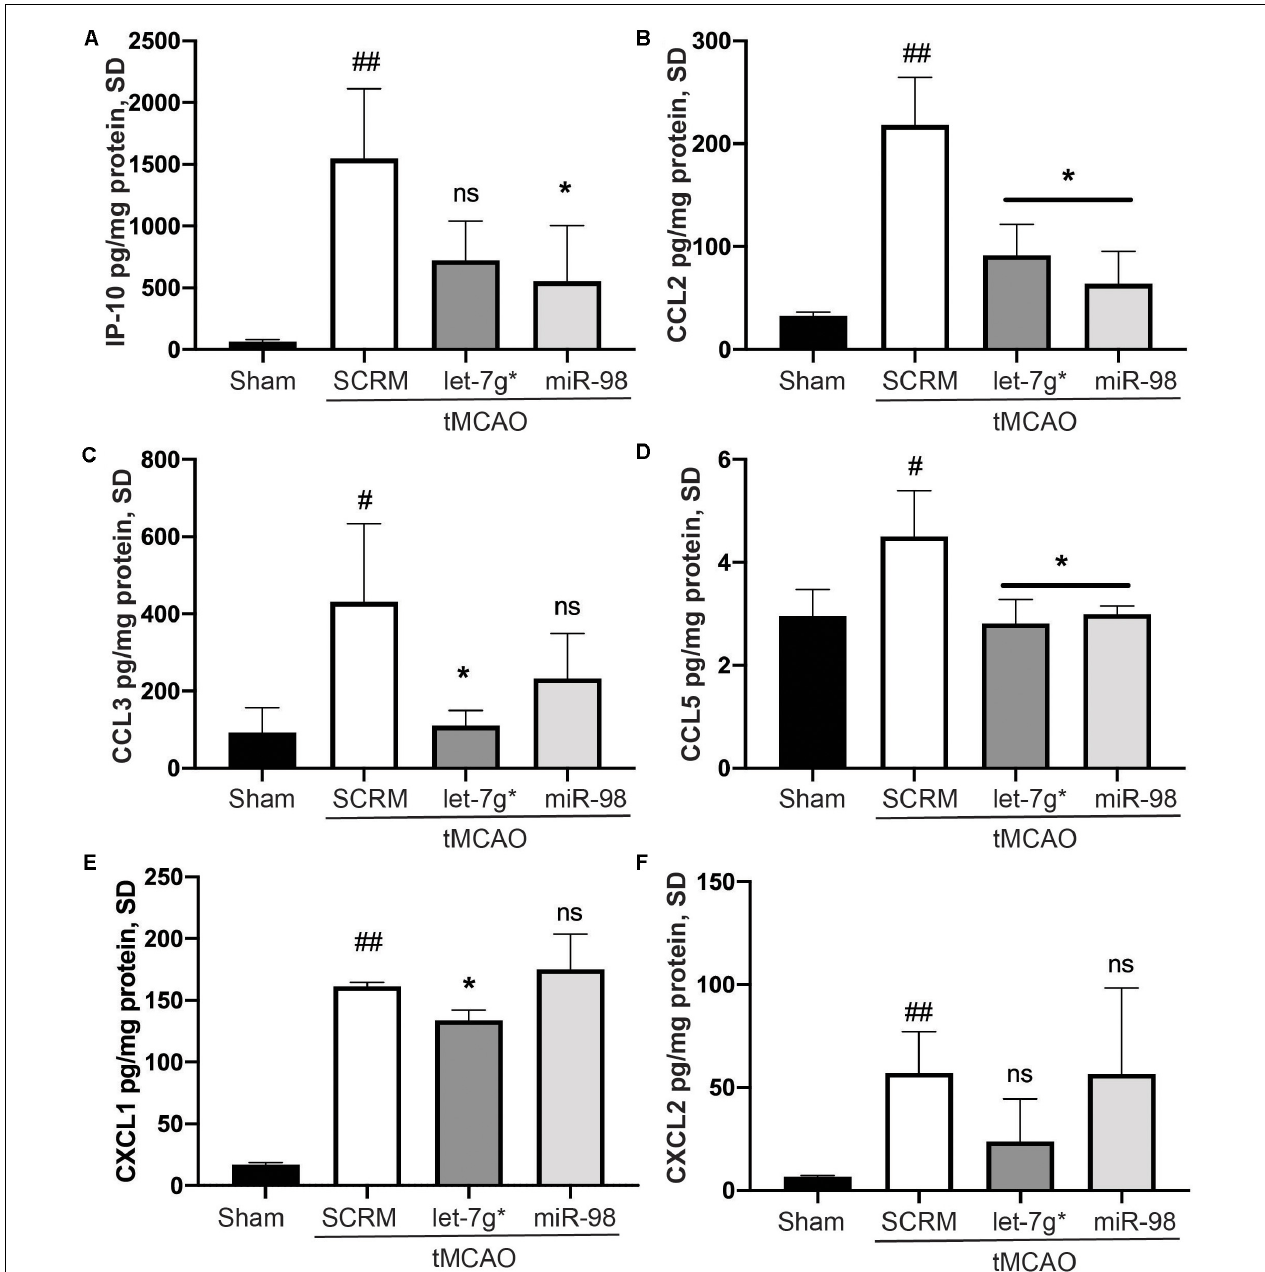
FIGURE 1 | Let-7 miRs differentially reduce cytokine release following stroke. ELISA analysis of IP-10 (A) , CCL2 (B) , CCL3 (C) , CCL5 (D) , CXCL2 (E) , and KC/GRO (CXCL-1 mouse analog) (F) expression. Mice were subjected to 60 min ischemia and 72 h reperfusion performed as described in section “Materials and Methods.” Brains were harvested following anesthesia, homogenized, and were used to run all assays. Results are presented as mean ± SD from at least two independent experiments ( n = 4). # p < 0.05 (SCRM); * p < 0.05 (let-7g*, miR-98). ## p < 0.01 (SCRM); ns is not